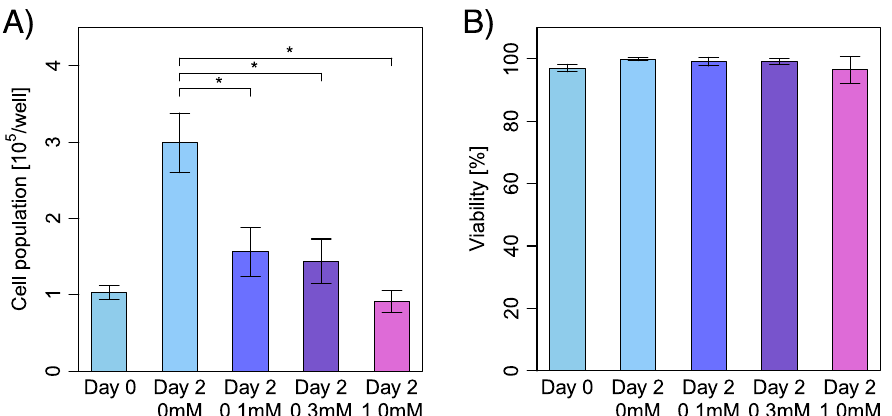
Fig. 1 Short exposure to H 2 O 2 induces a decrease of population doubling in a dose-dependent manner, but does not affect the cell viability in HEI-OC1 cells. a Population doubling time. Population doubling experiments were performed in duplicate. b Cell viability. Cell viability was determined by trypan blue staining at the indicated times after short exposure (1 h) with H 2 O 2 (0 μ M, 100 μ M, 300 μ M, and 1 mM). All values are showed as mean ± SD from three or more independent studies, n = 6 per group. * P <